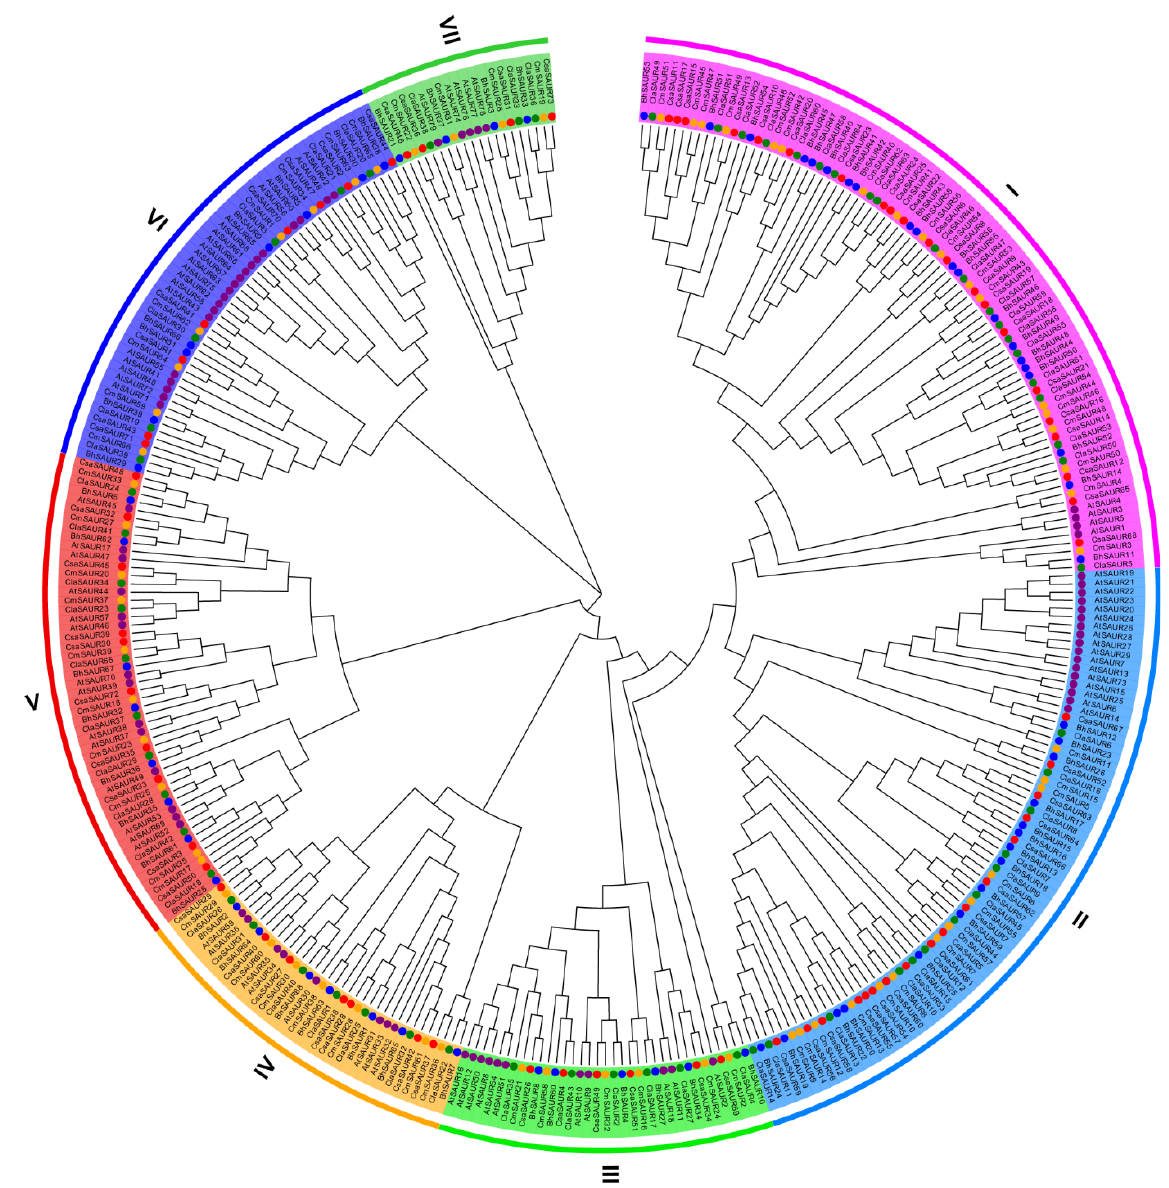
Figure 3. Phylogenetic tree of the SAUR family. The unrooted tree was constructed from all SAUR proteins of Arabidopsis (At), wax gourd (Bh), watermelon (Cla), melon (Cm), and cucumber (Csa). Different color circles represent different species. I – VII represent the seven subfamilies.